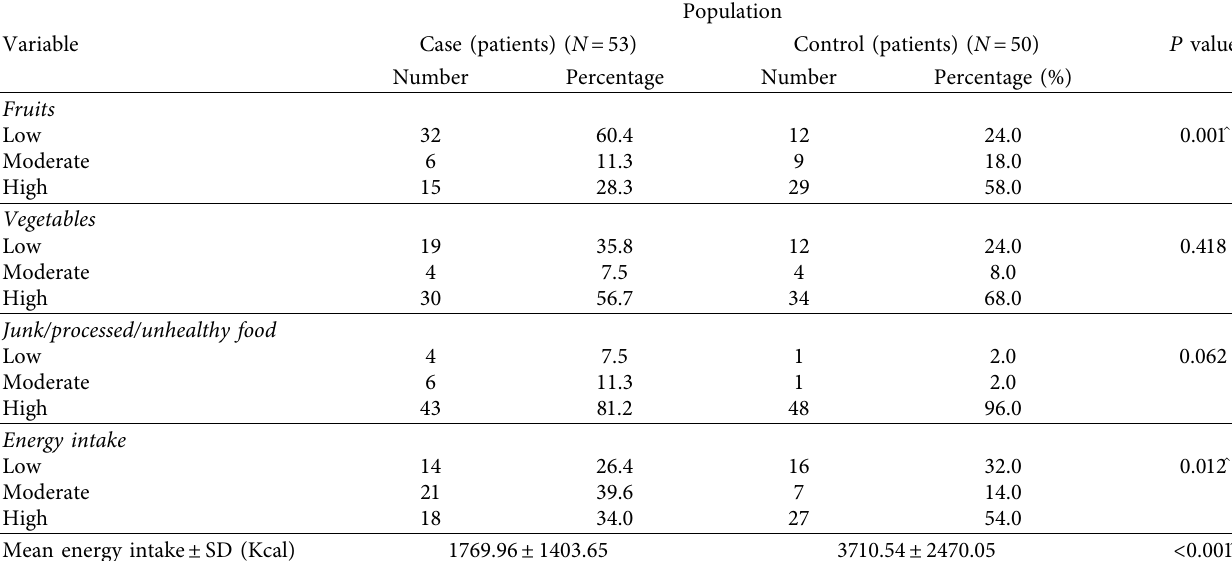
Table 2: Food frequency—case (patients) vs. control